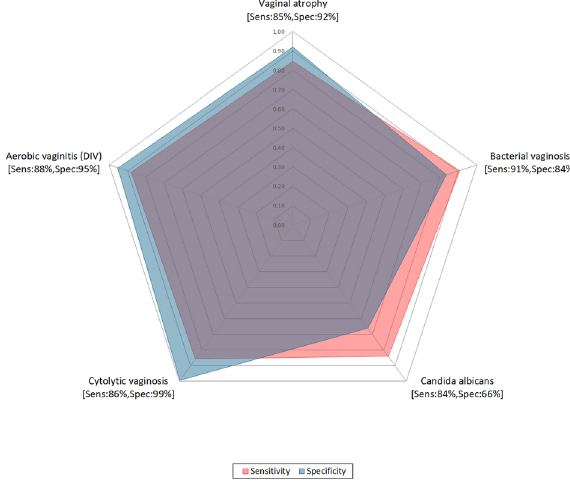
Fig. 1 The investigational test diagnostic performance chart. T. vaginalis and Candida non- albicans are excluded due to a low number of